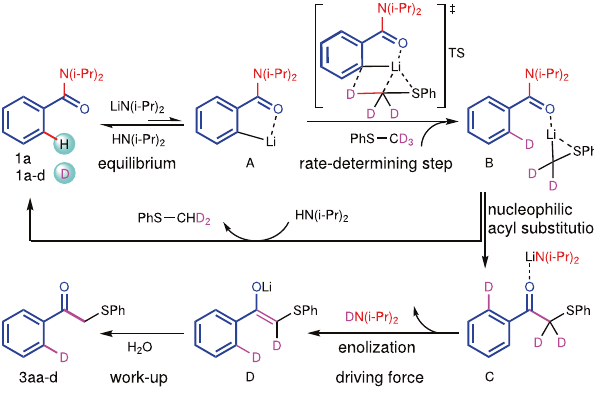
Fig. 5 A plausible reaction pathway. Intermediate A possibly exists in its